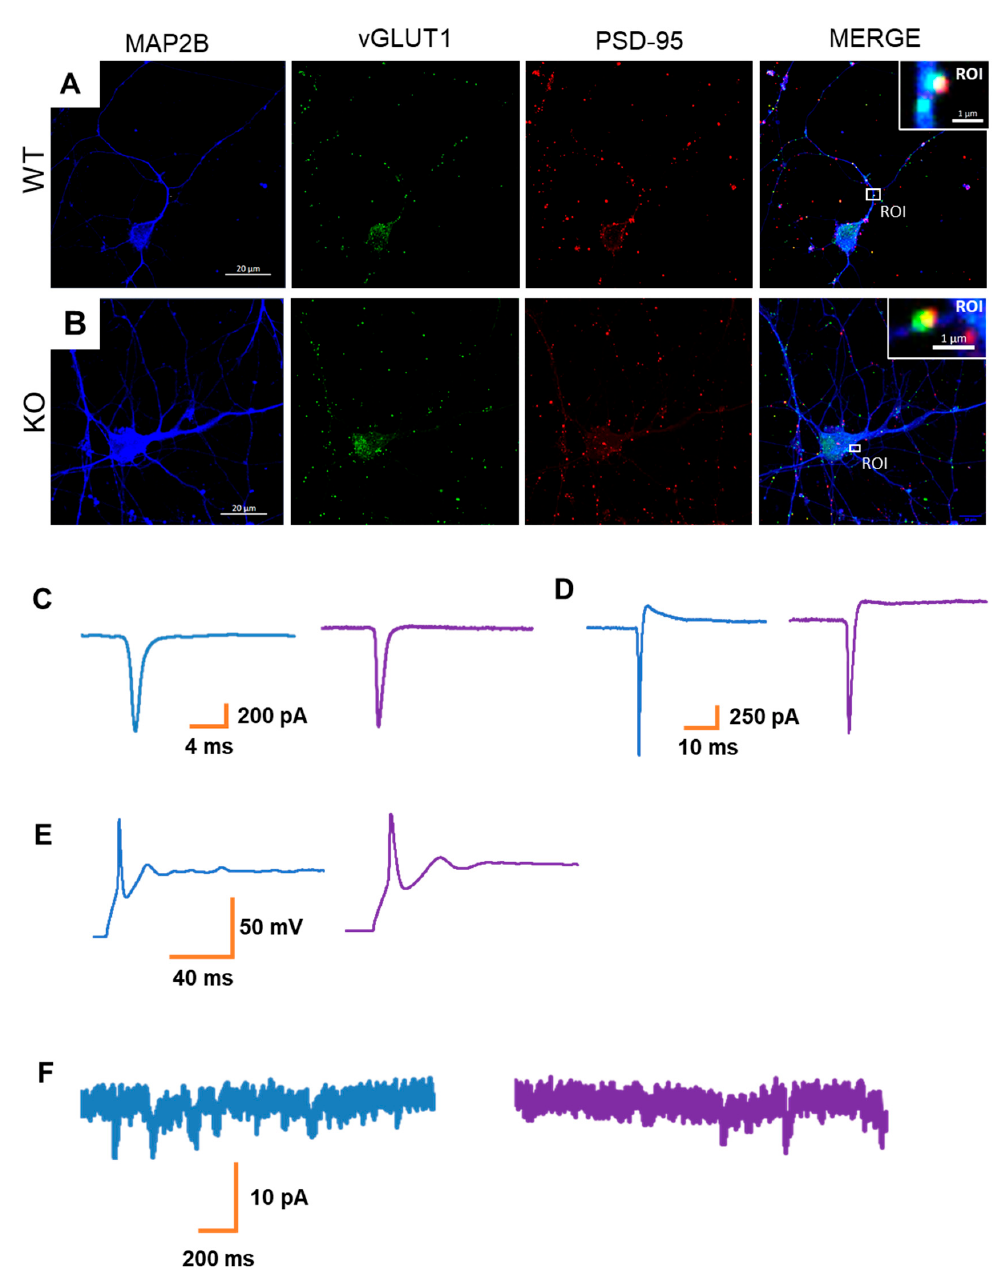
Figure 4. Synaptic connectivity and functionality of hiPSC-derived NPCs. ( A , B ) Representative images of wild-type ( A ) and MT5-MMP-deficient ( B ) neuronal cultures at 8 weeks of differentiation. The cells were immunostained by antibodies against MAP2B (blue), vGluT1 (green), and PSD-95 (red) as dendritic, pre- and postsynaptic markers, respectively. Scale bar 20 μ m. The white rectangle depicts the ROI. Note that the juxtaposed position of pre- and postsynaptic proteins, vGluT1 and PSD95, characterized by a small area of overlapping colors, was observed for both genotypes. Scale bar 1 μ m. ( C , D ) Representative traces from whole-cell patch-clamp recording showing that neurons were characterized by small Na + and K + currents at 60DIV. ( E ) Representative traces showing that neurons at 60DIV exhibited single action potentials in response to a depolarization step. ( F ) Representative traces from recorded neurons at 60DIV showed small inward spontaneous currents.